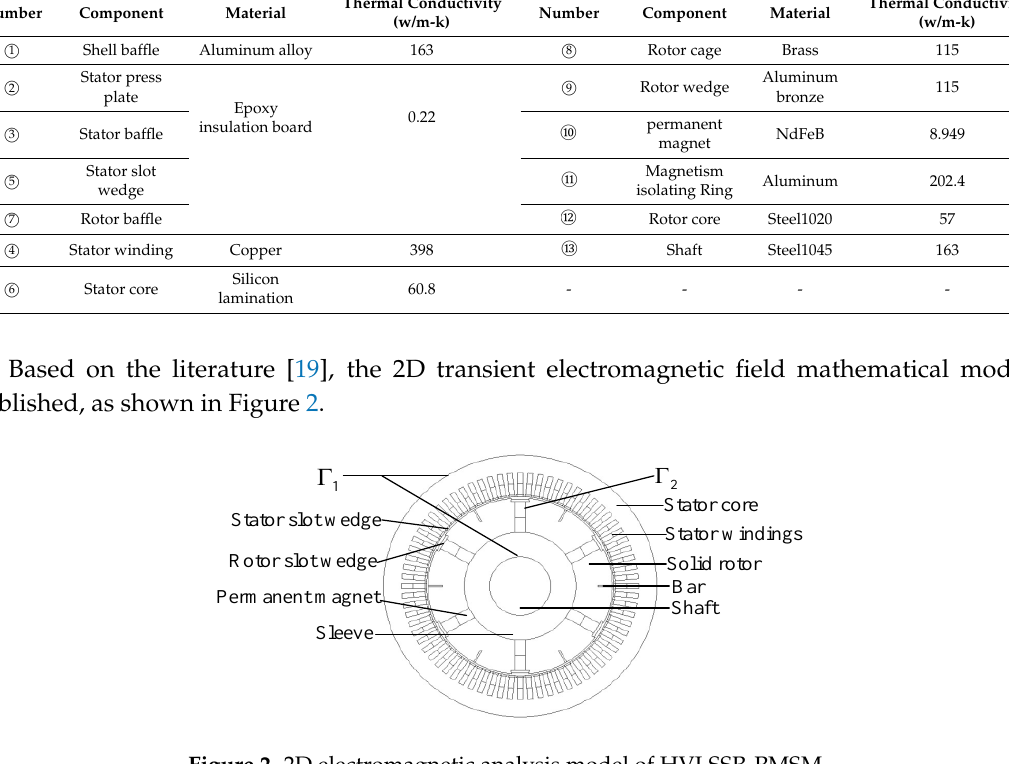
Figure 2. 2D electromagnetic analysis model of HVLSSR-PMSM.